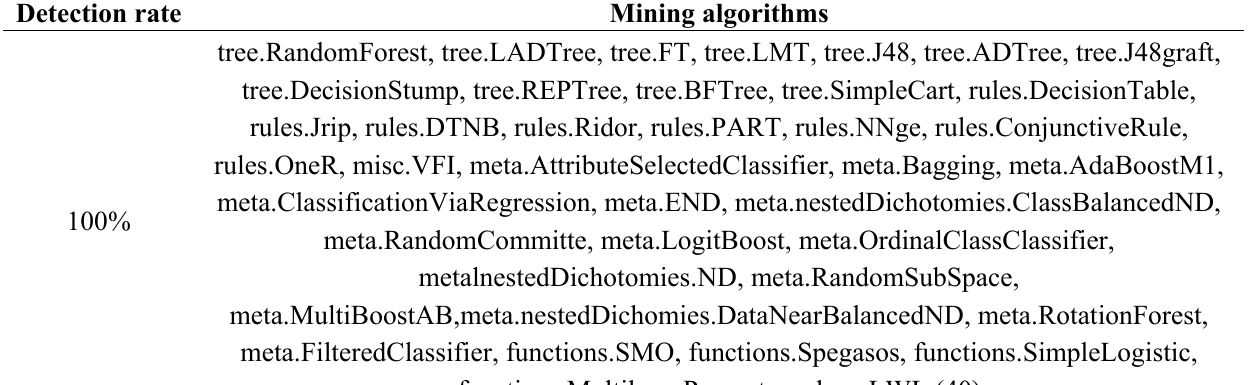
Table 4. Buffer overflow attack—data mining